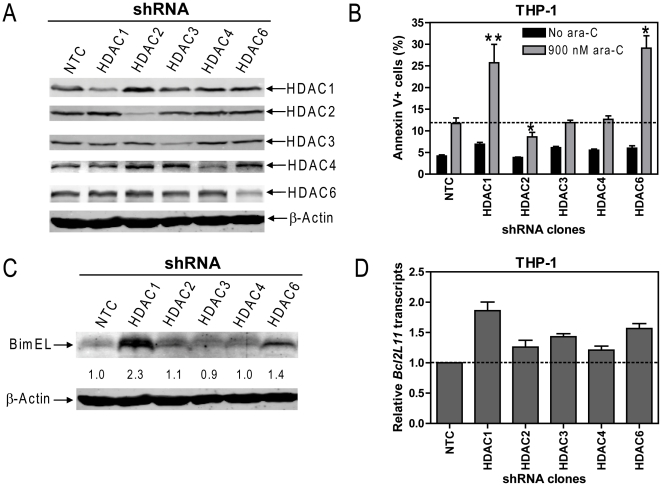
Effects of individual HDACs on cytarabine-induced apoptosis in THP-1 cells.
Panel A: THP-1 cells were infected by HDAC1, HDAC2, HDAC3, HDAC4, HDAC6 or negative (NTC) control shRNA lentiviruses. After selection with puromycin, infected THP-1 cells were expanded and subjected to Western blotting and probing with anti-HDAC1, -HDAC2, -HDAC3, -HDAC4, -HDAC6, or -β-actin antibody. Panel B: shRNA stable clones were treated with 900 nM cytarabine for 48 h and early and late apoptosis events were measured using annexin V/PI staining and flow cytometry analysis. The horizontal line indicates the mean of cytarabine-induced apoptosis in the NTC-shRNA clone. Panel C: Whole cell lysates from shRNA stable clones were extracted and subjected to Western blotting probed by anti-Bim or -β-actin antibody. Panel D: Total RNAs were isolated from the shRNA stable clones and reverse transcribed to cDNA. Transcripts for Bcl2L11 (encode Bim) were quantitated using a LightCycler real-time PCR machine. Real-time PCR results are presented as mean values from 3 independent experiments using the same cDNA preparation and normalized to GAPDH. **, p<0.005; *, p<0.01.